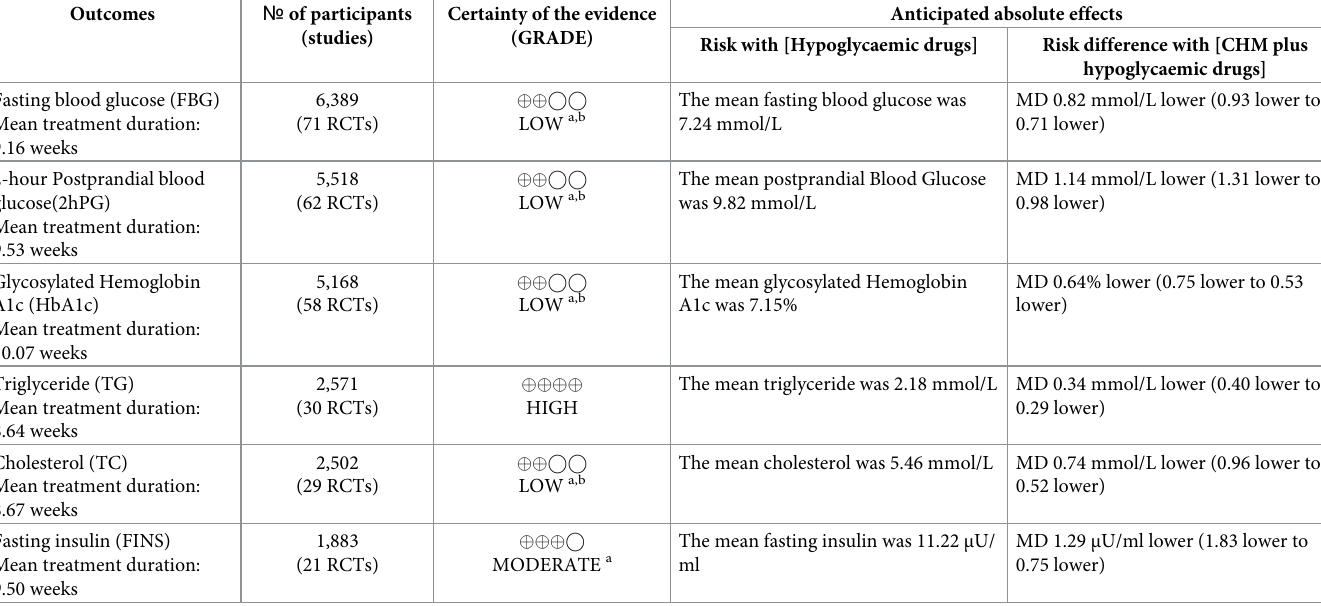
Table 4. GRADE: Quality of the evidence of Fuling formulae for T2DM, CHM plus Hypoglycaemic agents vs. Hypoglycaemic agents. Outcomes № of participants Certainty of the evidence (studies) (GRADE) Risk with [Hypoglycaemic